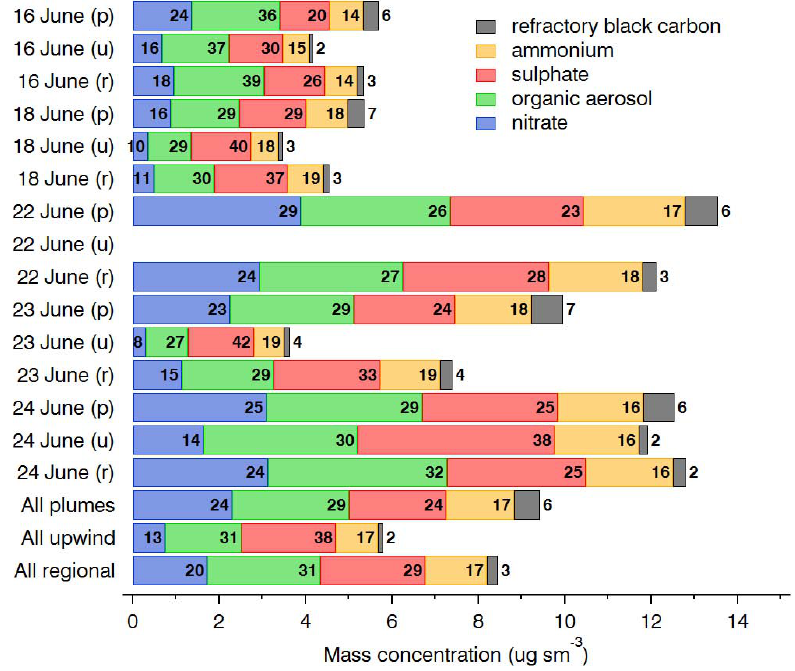
Fig. 10. Mass concentrations of AMS- and SP2-measured species averaged over London plume (p), upwind of London segments (u) and regional segments (r) for each flight as well as the campaign-averaged values for each category. Black numbers indicate the mass fraction (%) of each species relative to the corresponding total sub-micron